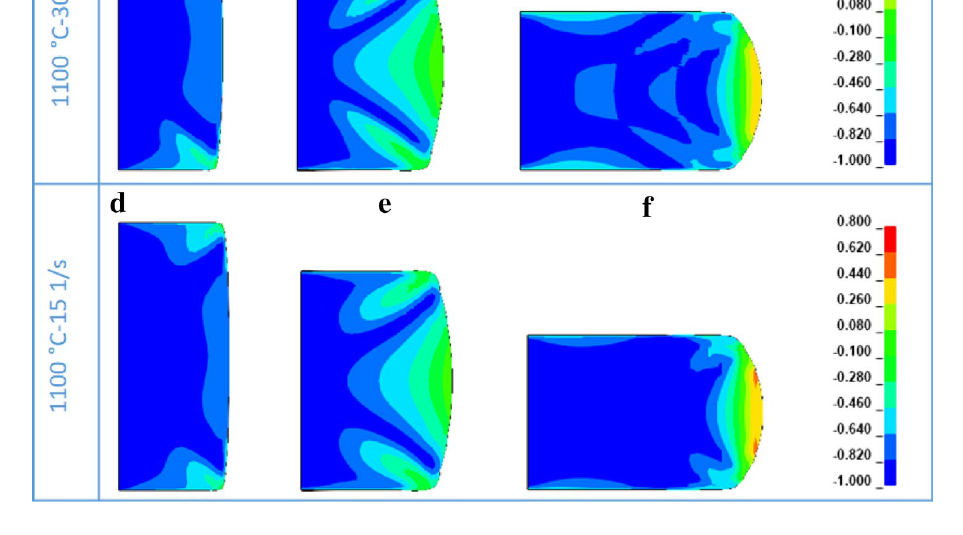
Fig. 10 Tracked points and lines in the